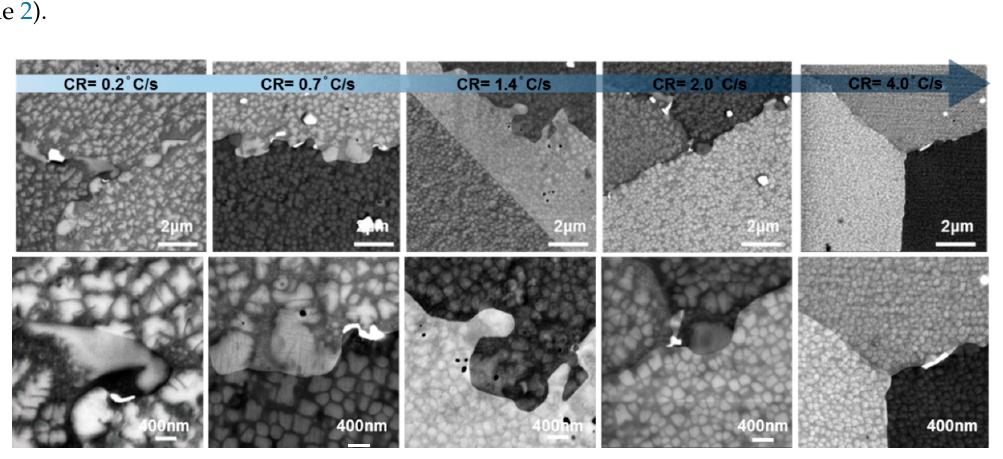
Figure 2. Backscattered SEM images of the microstructures developed in the samples after cooling from solution temperature at each cooling rate given. The magnification used was ≈ ×20,000 for the first row and ≈ ×50,000 for the second. Table 2. Parameters for the double-Gaussian fit for each cooling rate.